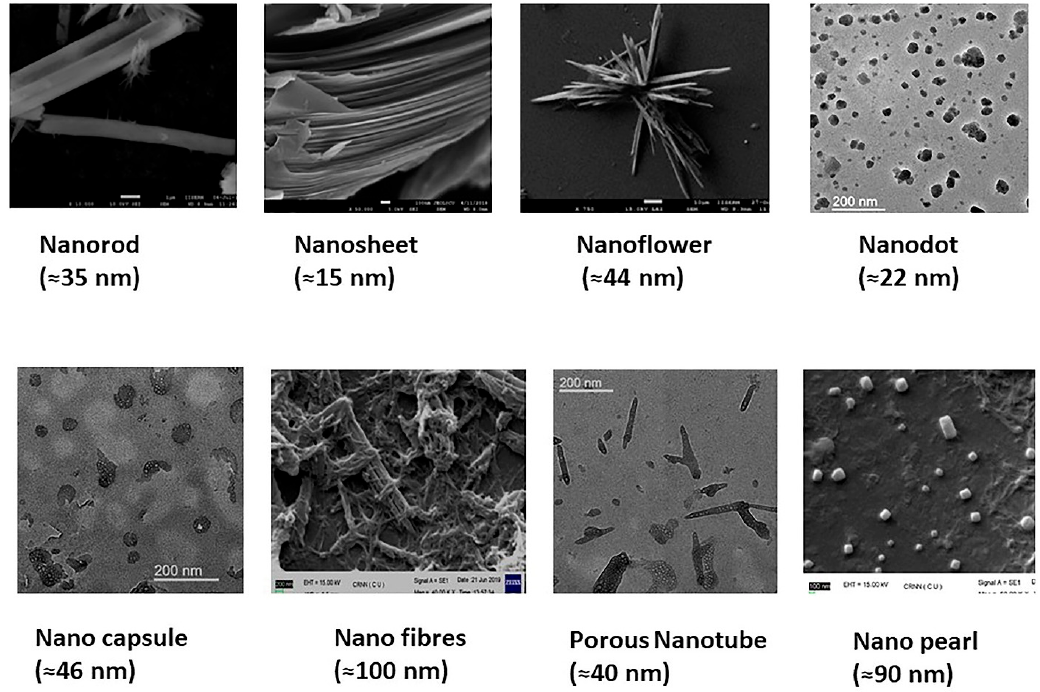
Figure 1. Nanomaterials of different shapes and sizes.